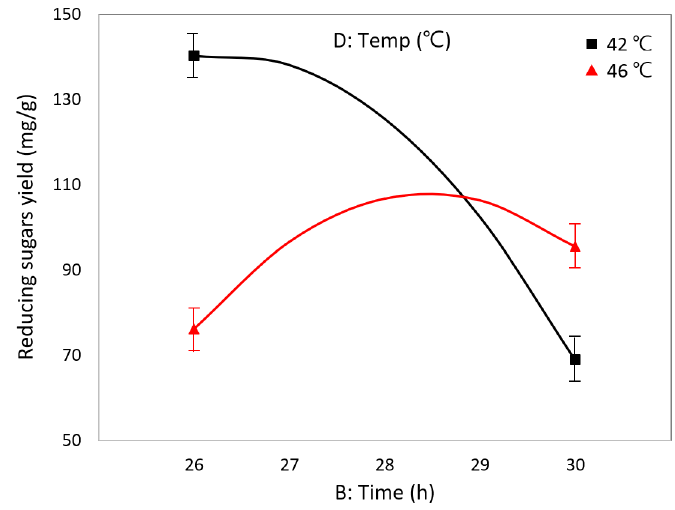
Figure 4. Interaction effects of time and